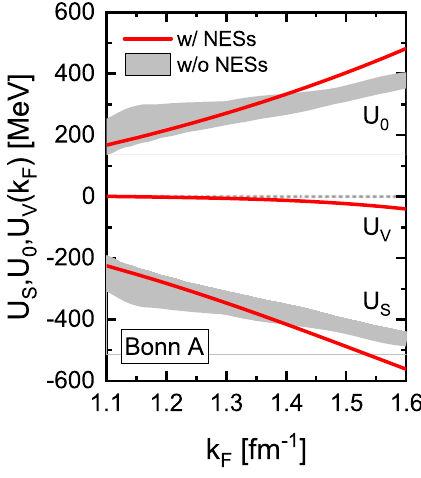
Figure 2. The di ff erent contributions to the single particle poten- tial in Eq. (7). Results in full Dirac space (red) are compared with those, where the NES are treated approximately (shaded gray). Figures taken from Ref.